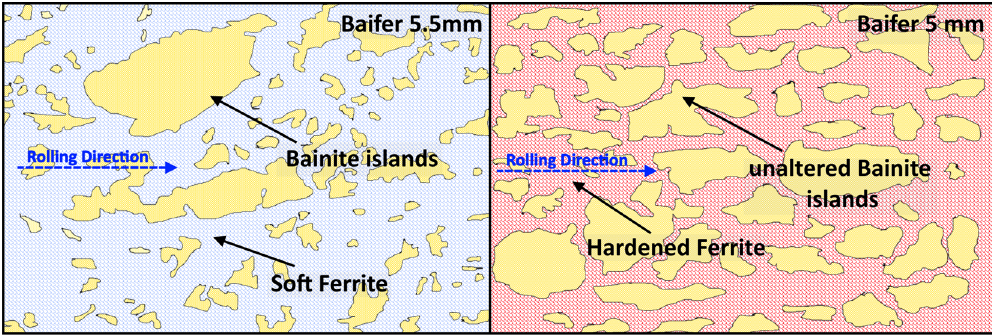
Figure 13. Unaltered bainite islands were shifted inside the hardened matrix. The whole strain hardening is withstood by ferrite (light blue when unaltered, red when hardened).